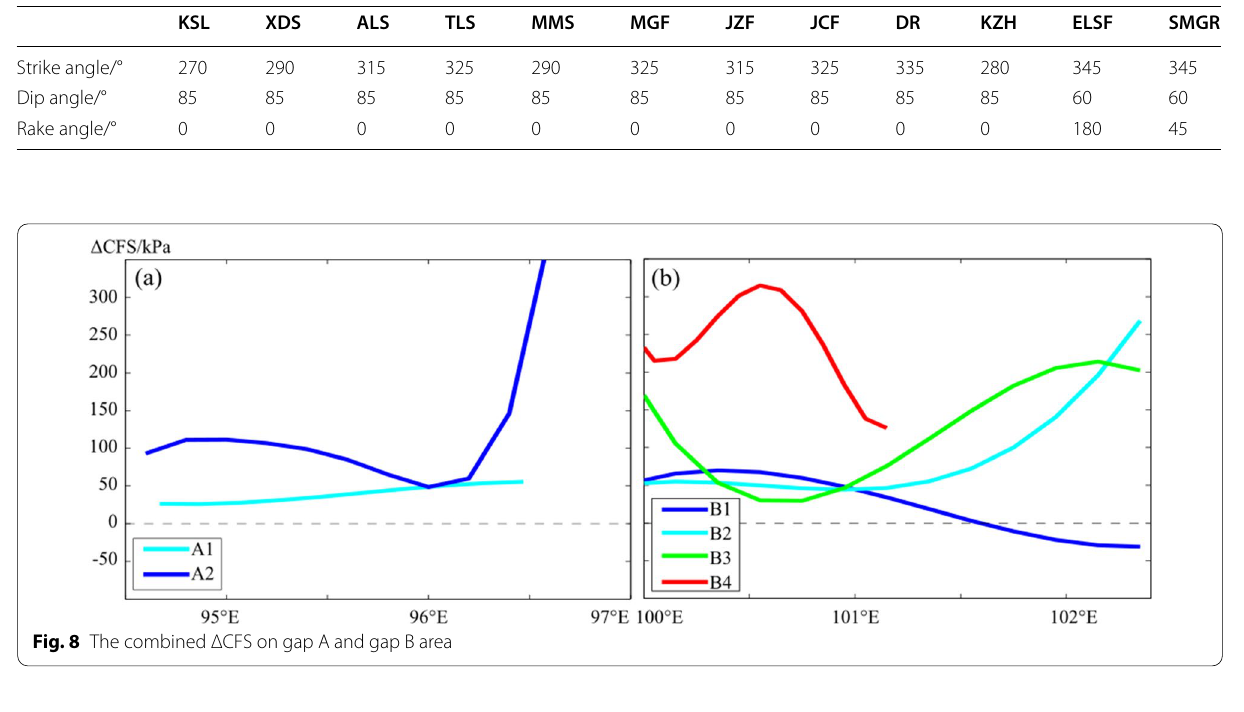
Table 3 Geometric parameters of each fault